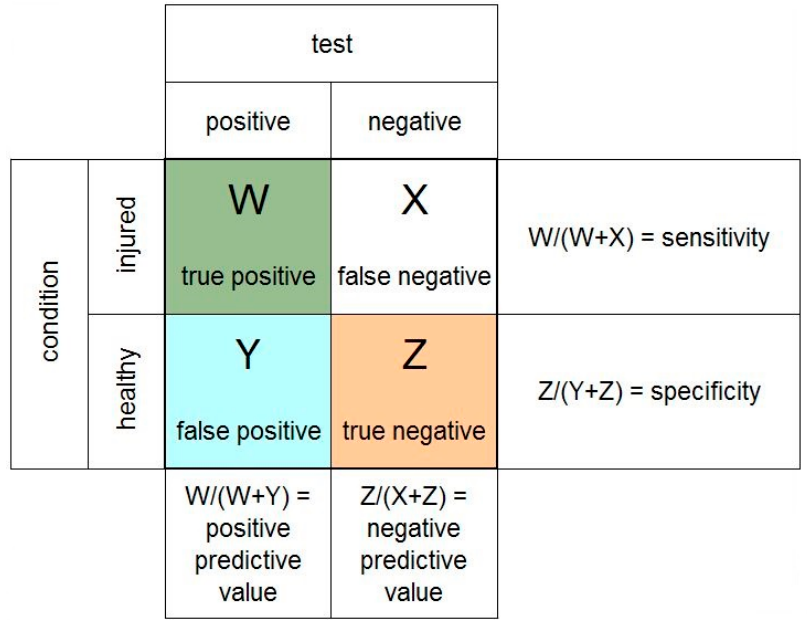
Figure 3. Model of exemplary fourfold table.